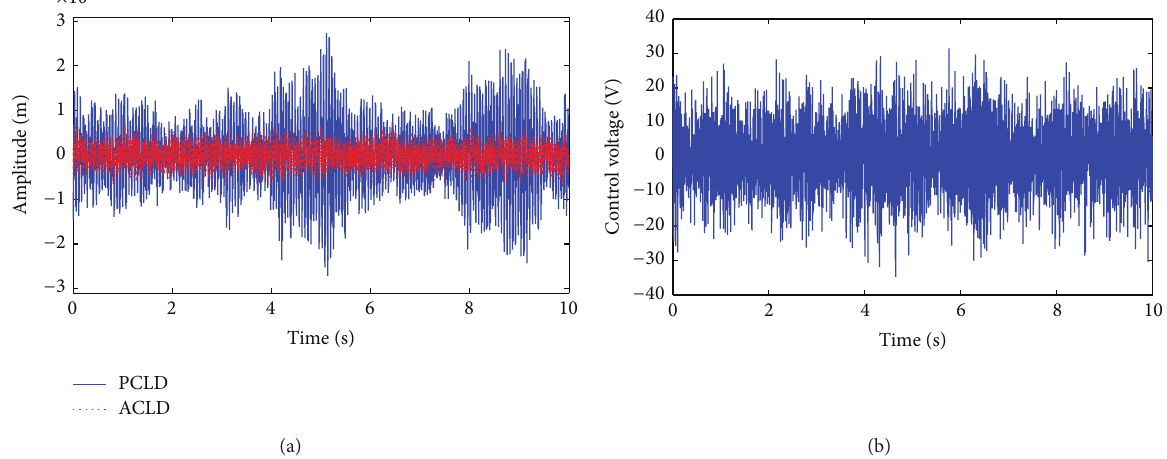
Figure 6: The displacement and control voltage for a white noise disturbance using the LQG feedback control: (a) the displacement response, (b) the control